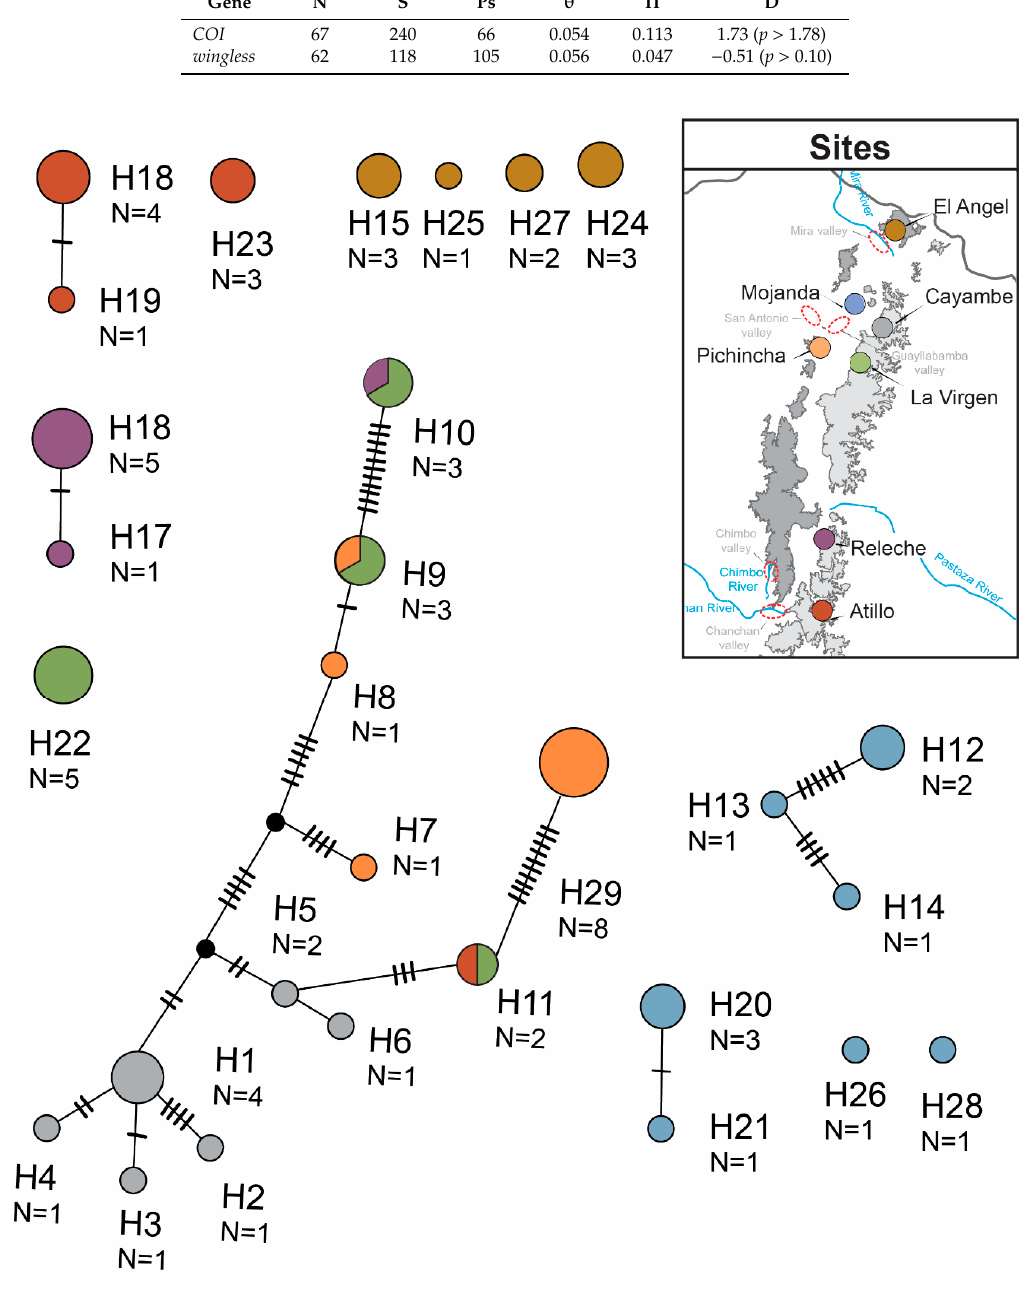
Figure 2. TCS haplotype networks for the COI gene of Panabachia .